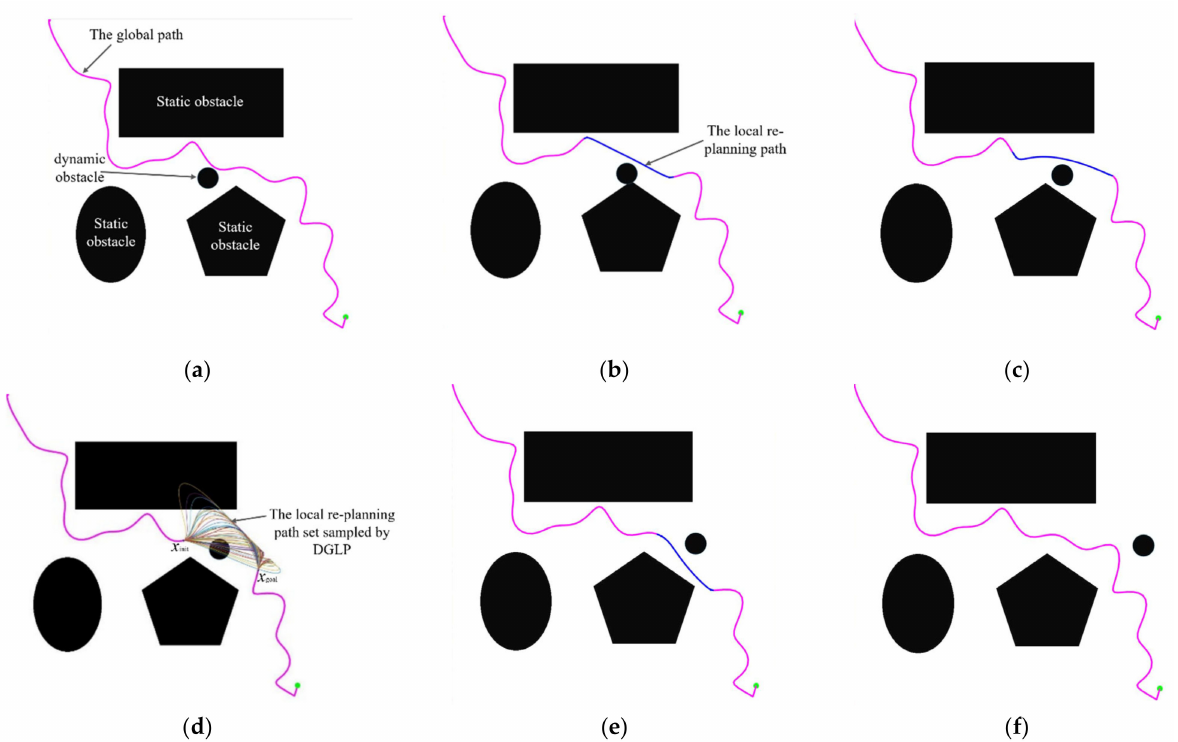
Figure 5. The DGLP re-plans the local paths online in a dynamic environment. ( a ) The dynamic obstacle is moving from left to right in the environment. ( b ) The dynamic obstacle invalidates a part of the global path and the DGLP provides a local re-planning path online. ( c ) As the movement of the obstacle, the previous local path collides with the obstacle, and a new feasible local path is quickly generated by the DGLP. ( d ) The DGLP samples 100 alternate local paths to select a high-quality collision-free local path. ( e ) The local re-planning path from the DGPL is smooth and its ends all satisfy orientation constraints to merge into the global path smoothly. ( f ) The dynamic obstacle no longer collides with the global path, and thus the global path returns to the original